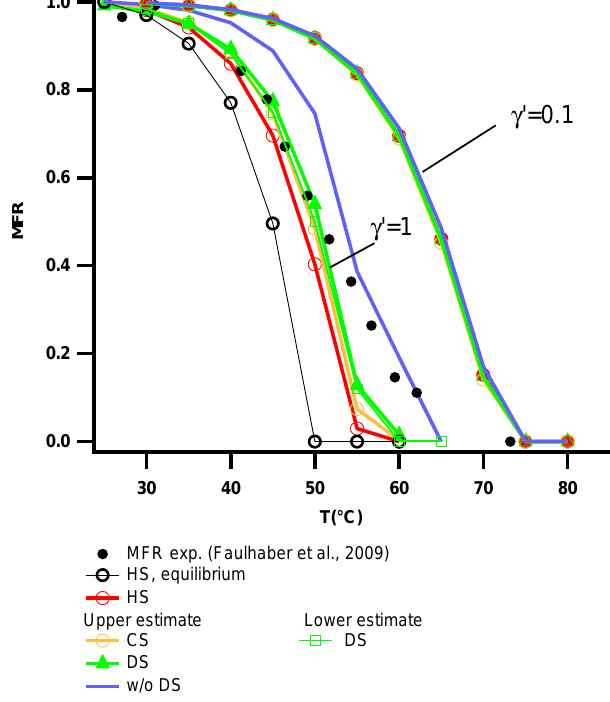
Fig. 7. Output thermograms and recondensation fraction for the heating section (HS), cooling section (CS), denuder section (DS) and equivalent configuration without denuder section (w/o DS), in a system with 200nm butanedioic particles at 150µgm − 3 aerosol loading, in comparison with experiments by Faulhaber et al. (2009). The results show a best fit between observations and model for a kinetic coefficient close to unity. Upper estimate: upper estimate for re-condensation (no mass transfer to walls); lower estimate: lower estimate for re-condensation (equilibrium wall